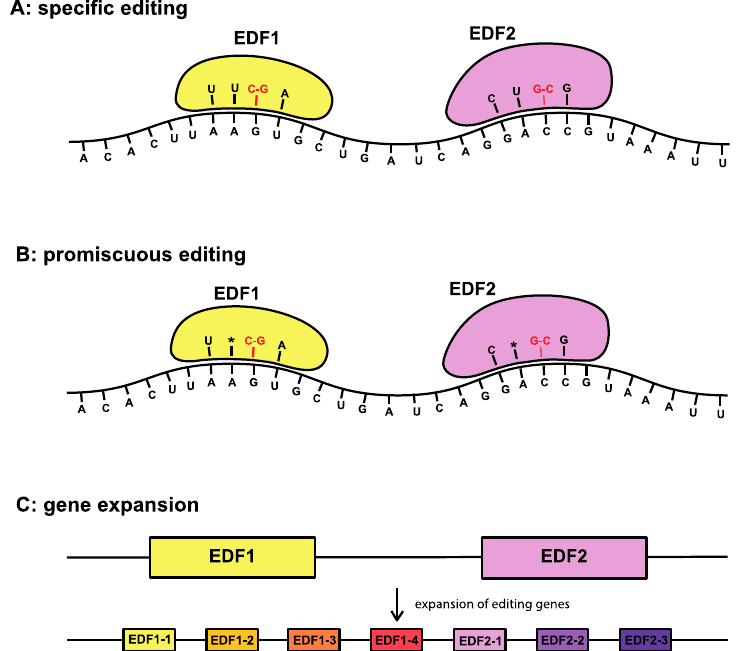
Figure 4. Possible models of transcript editing with editing factors (EDFs). ( A ) Specific editing, where specific EDFs are responsible for facilitating edits on matching regions of the transcript. ( B ) Promiscuous editing, where there is some flexibility in the possible matches that any one EDF can make, or what conversions are possible. ( C ) Gene expansion, where a small group of ancestral EDFs expand within the genome and evolve different specificities to transcript sequences or possible base conversions.